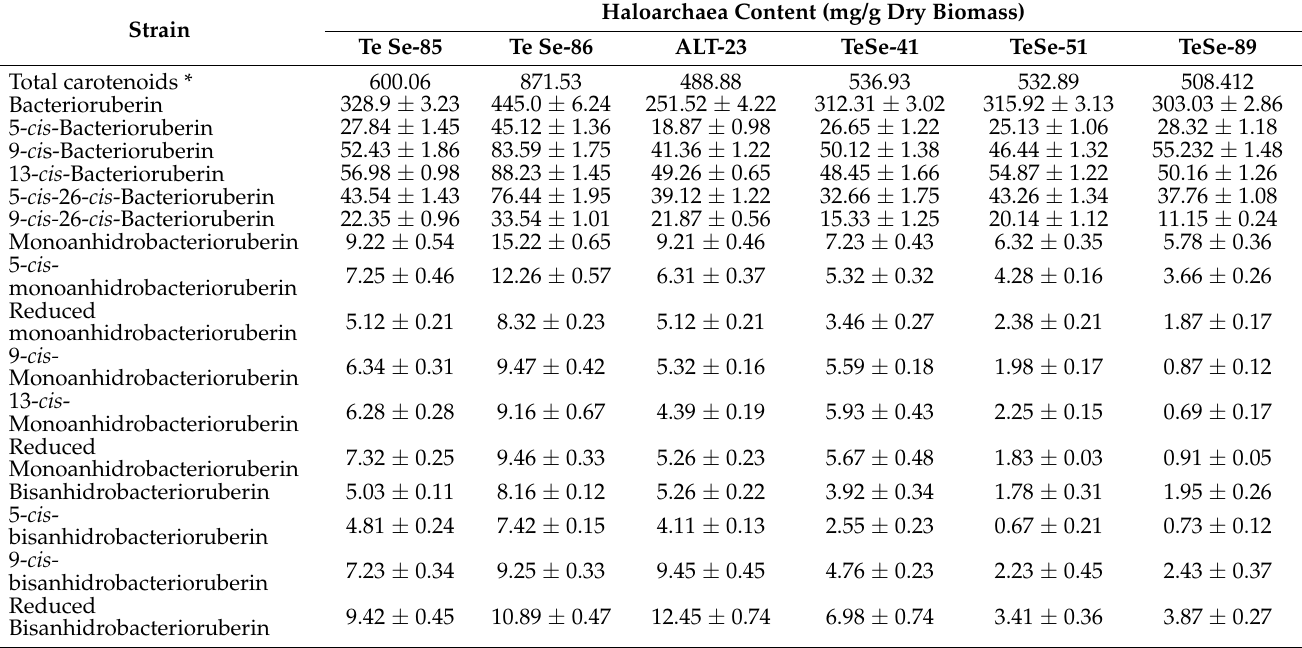
Table 3. Total bacterioruberin carotenoids in haloarchaea: Te Se-85, Te Se-86, ALT-23, TeSe-41, TeSe-51 and TeSe-89 by UHPLC